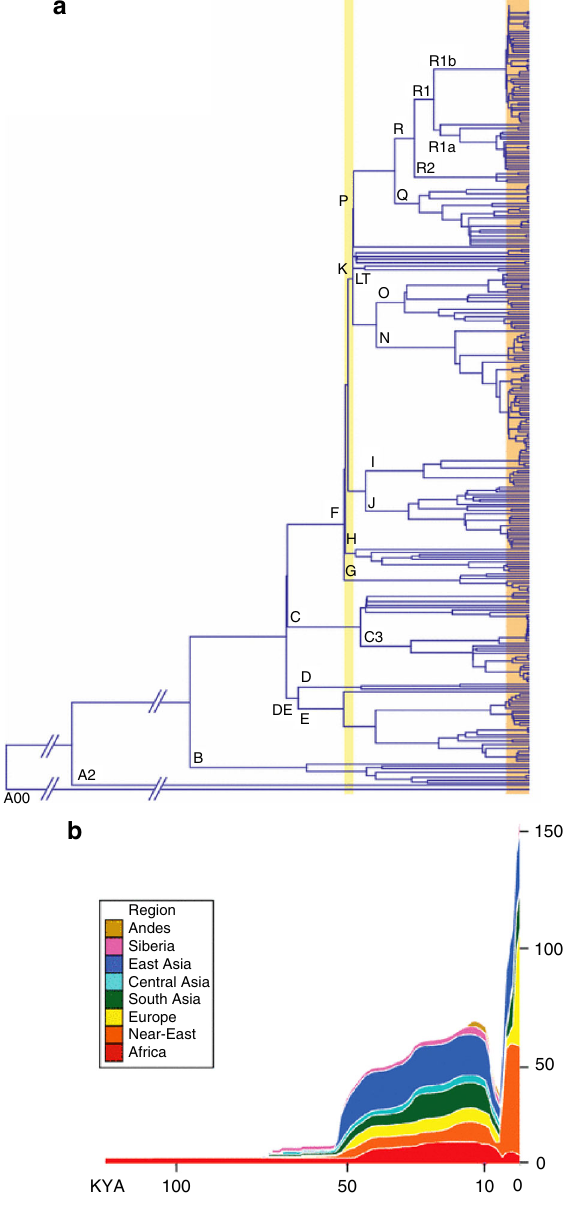
Fig. 3 Male-speci fi c Y (MSY) chromosome phylogeny from next- generation sequencing data, and associated demographic reconstruction. a MSY phylogeny based on 456 samples and 35,700 SNPs. Major haplogroups are labelled. The orange box highlights recent expansions identi fi ed in several haplogroups, and the yellow box highlights more ancient expansion of deep-rooting lineages. b MSY Bayesian Skyline Plots (of effective population size against time), with different world regions indicated by colours as shown in the key. Reprinted from Batini